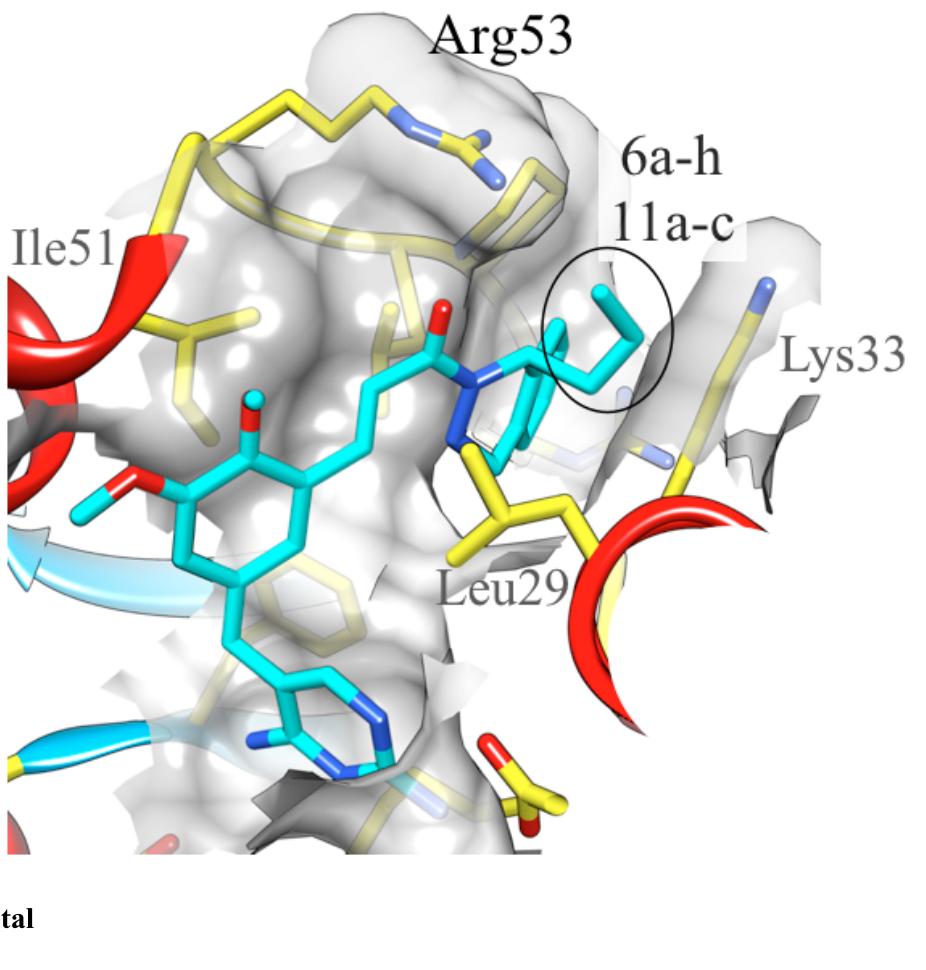
Figure 1. Interactions between the DHFR protein and the RAB1 (R = n –Pr) inhibitor. This structure illustrates the position of substituents R at the C1 stereocenter of the dihydrophthalazine with a black oval; selected residues are labeled. It is hypothesized that the superior potency of compound 6e (R = cyclopropyl) results from stacking interactions with the guanidinium group of Arg